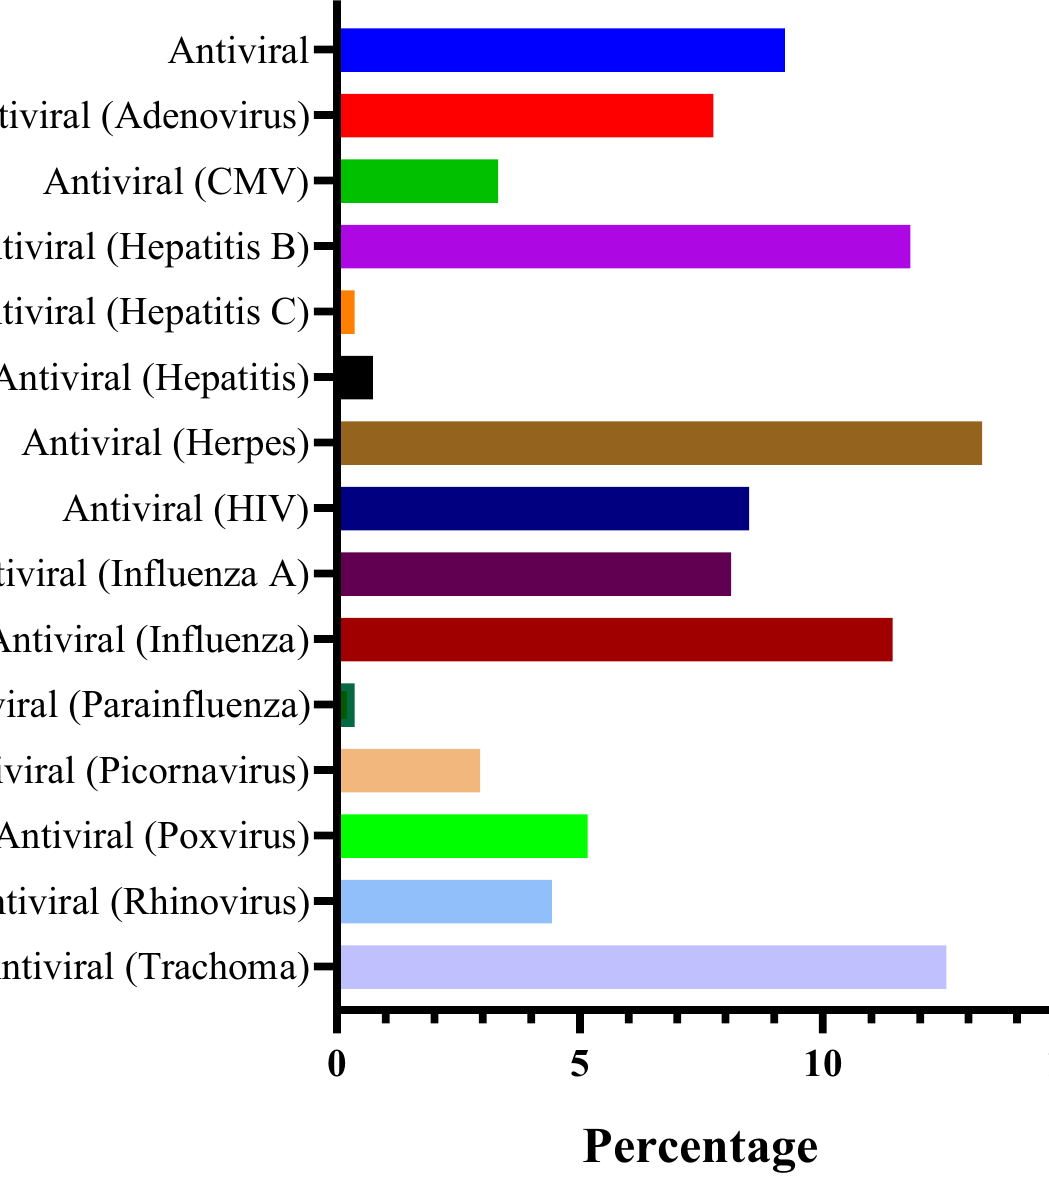
Fig. 3 Predicted anti-viral activity of anthraquinone derivatives against multiple